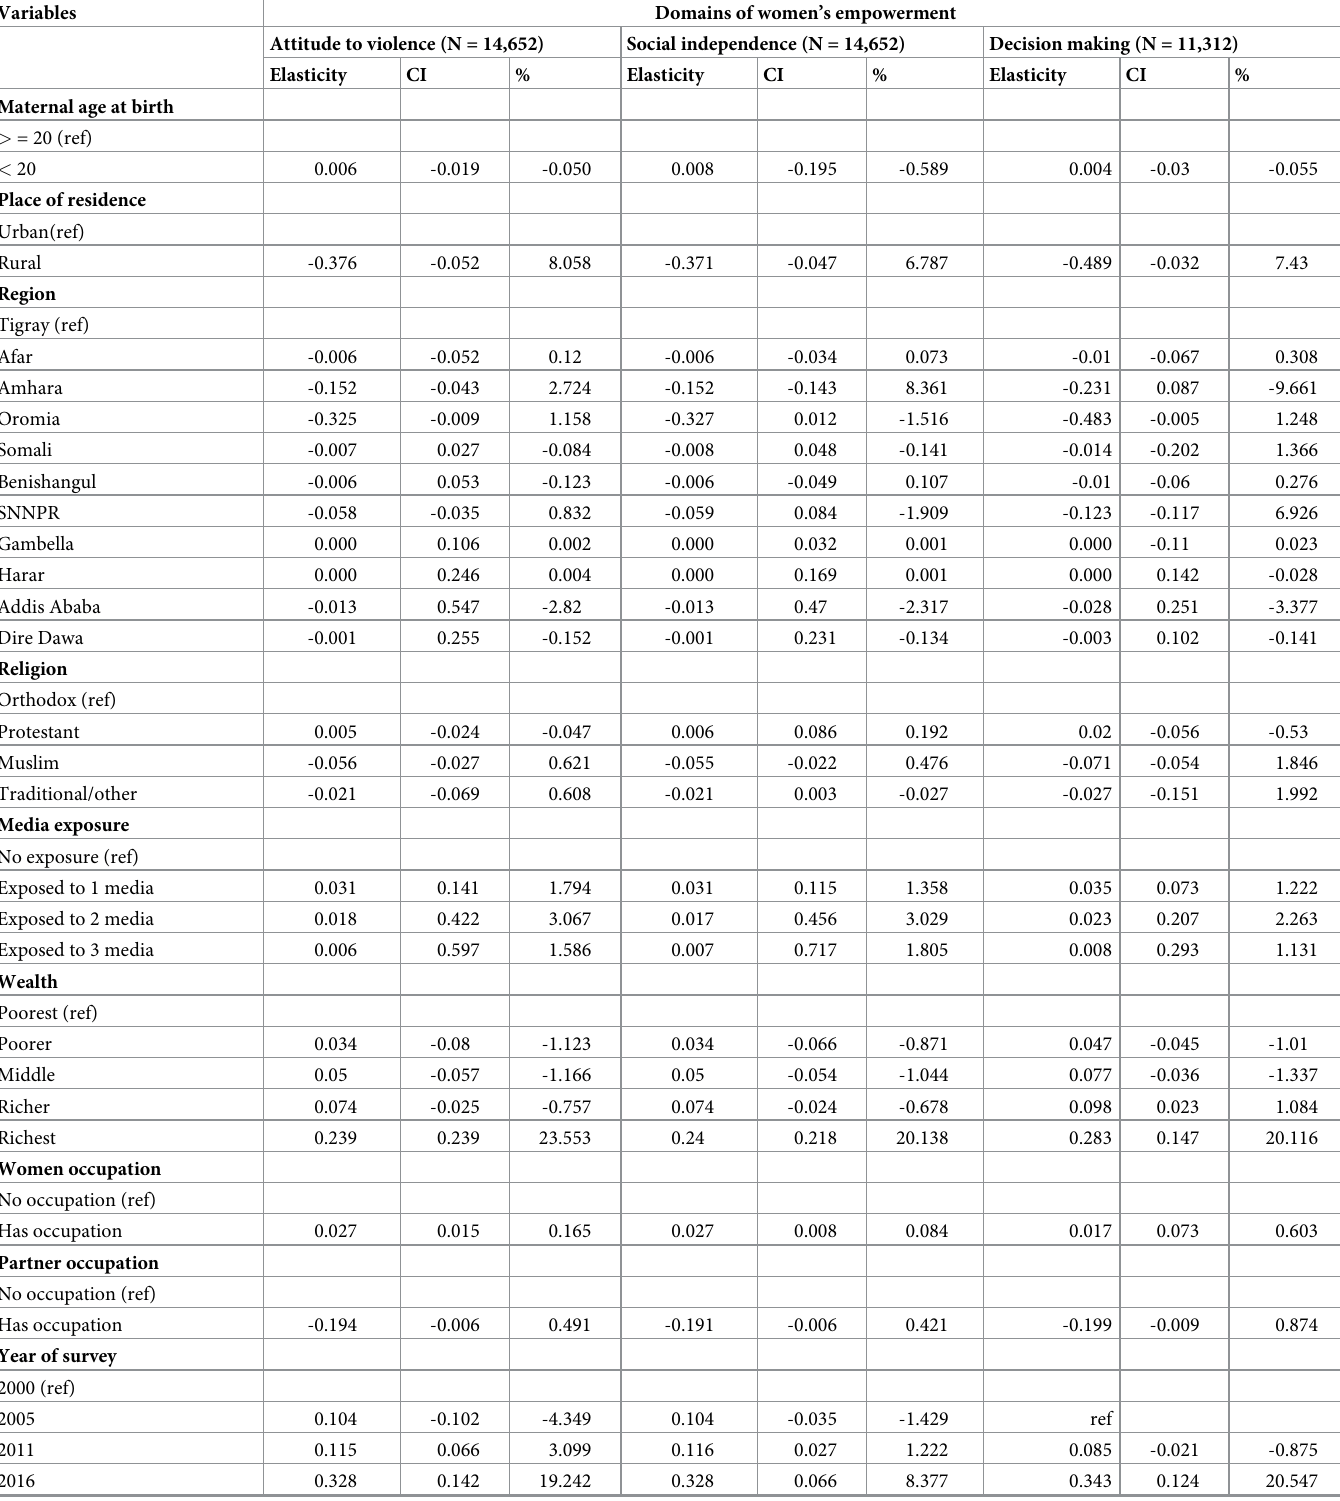
Table 5. Decomposition of the inequalities in the usage of PNC within 2 days of birth by women’s empowerment, 2000–2016